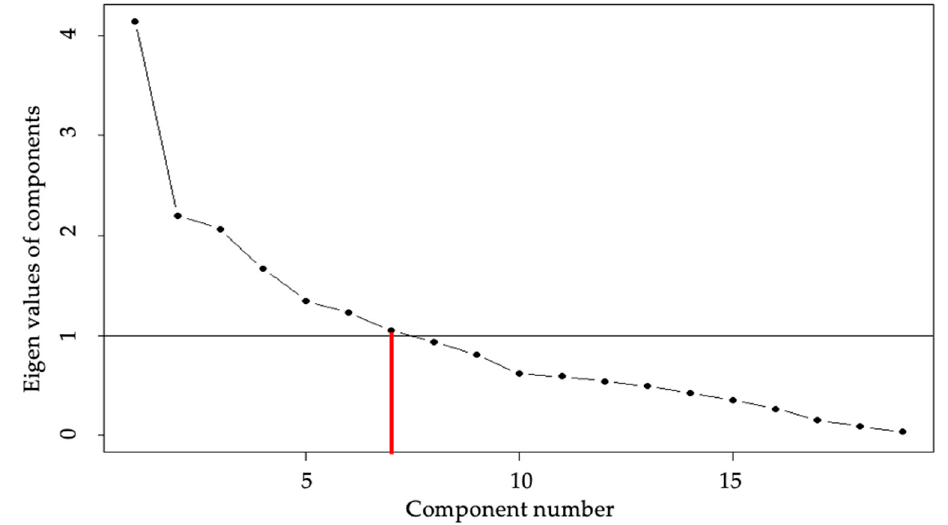
Figure 3. Scree plot from PCA results for selecting components. Figure 4 illustrates the contribution of variables to the PCs. Black lines indicate positive contribution and red lines indicate negative contribution. Higher degrees of land ownership, sown area, number of crops and crop income contribute to component 1. Age and experience variables contribute to component 2. Component 3 is highly crop diversified with high cereal intensity and high in marketing mode indices. Higher marketing mode indices indicate the ability of the farmer to take the produce to the vendor. Component 4 reflects the higher degree of N use and irrigated area. Education and